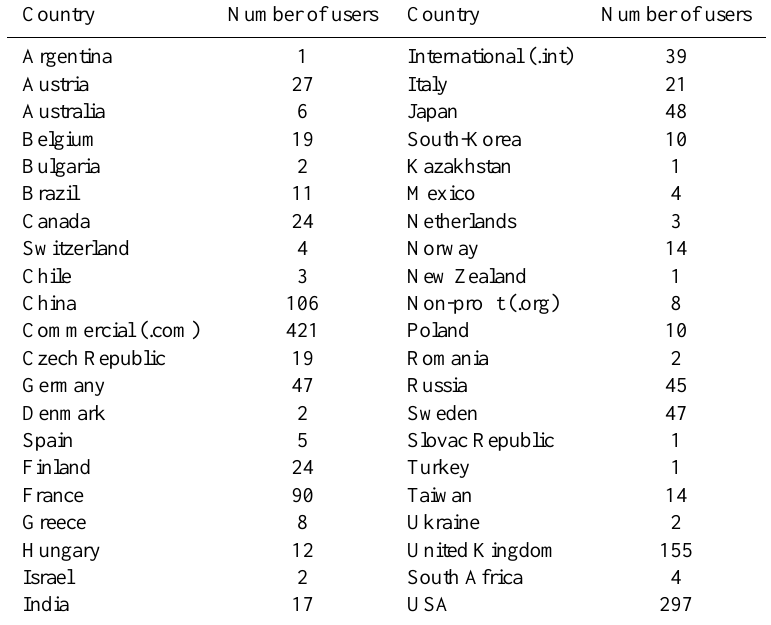
Table 6. Cluster Active Archive users (based on